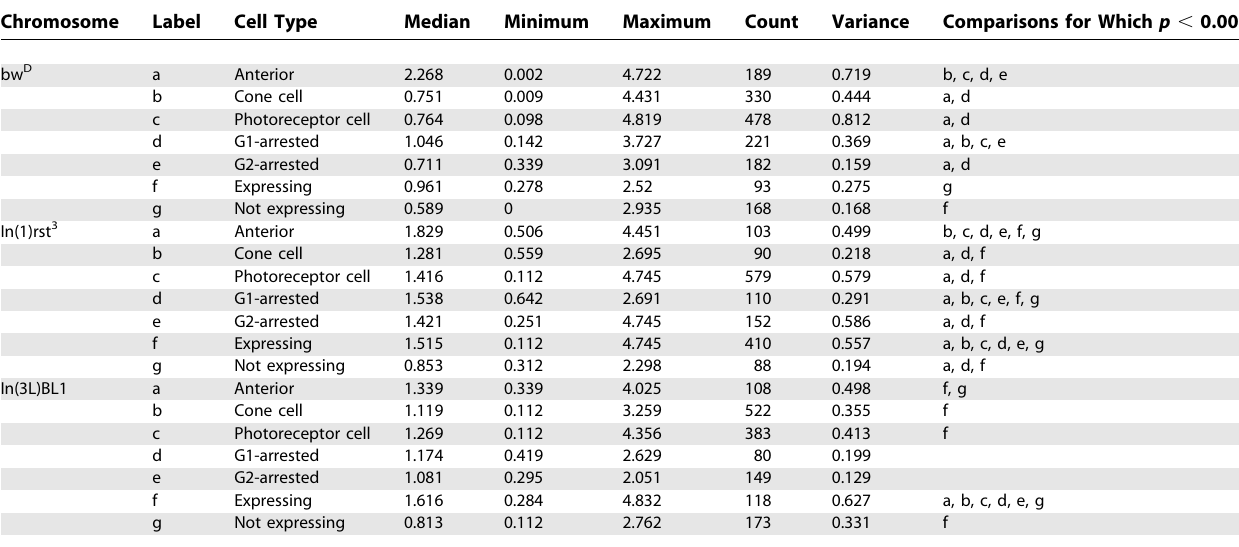
Table 1. Summary of Reported Results Chromosome